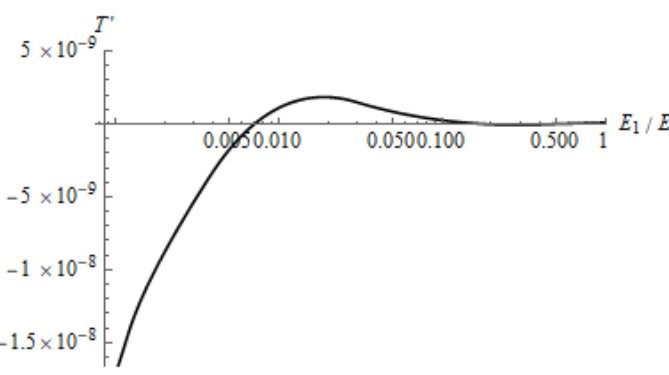
0.48 ν = , 0.3 ν = 1 2